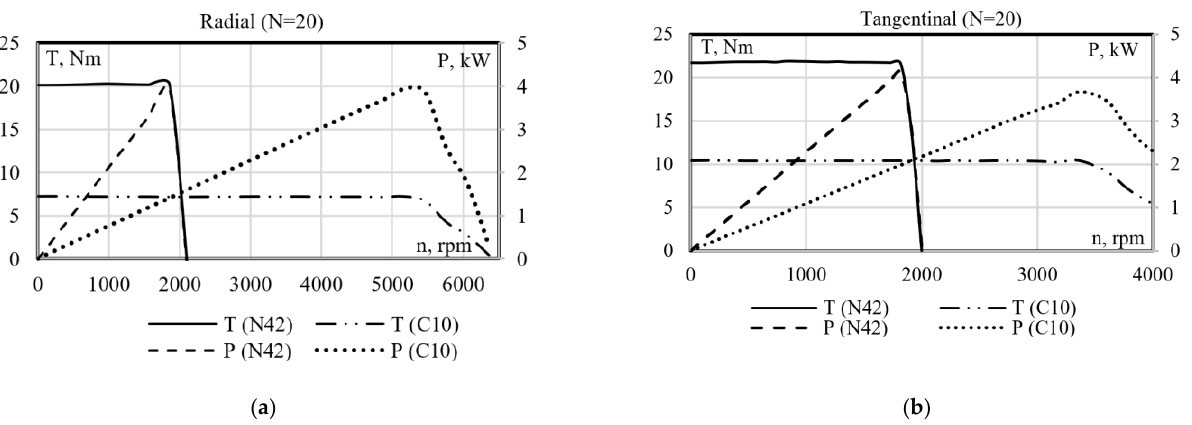
Figure 4. Electromechanical characteristics of the tangential and radial machines with N42 and C10 PMs for N = 20 turns. Here, the X -axis defines the speed of the machines and the Y -axis shows the torque and output